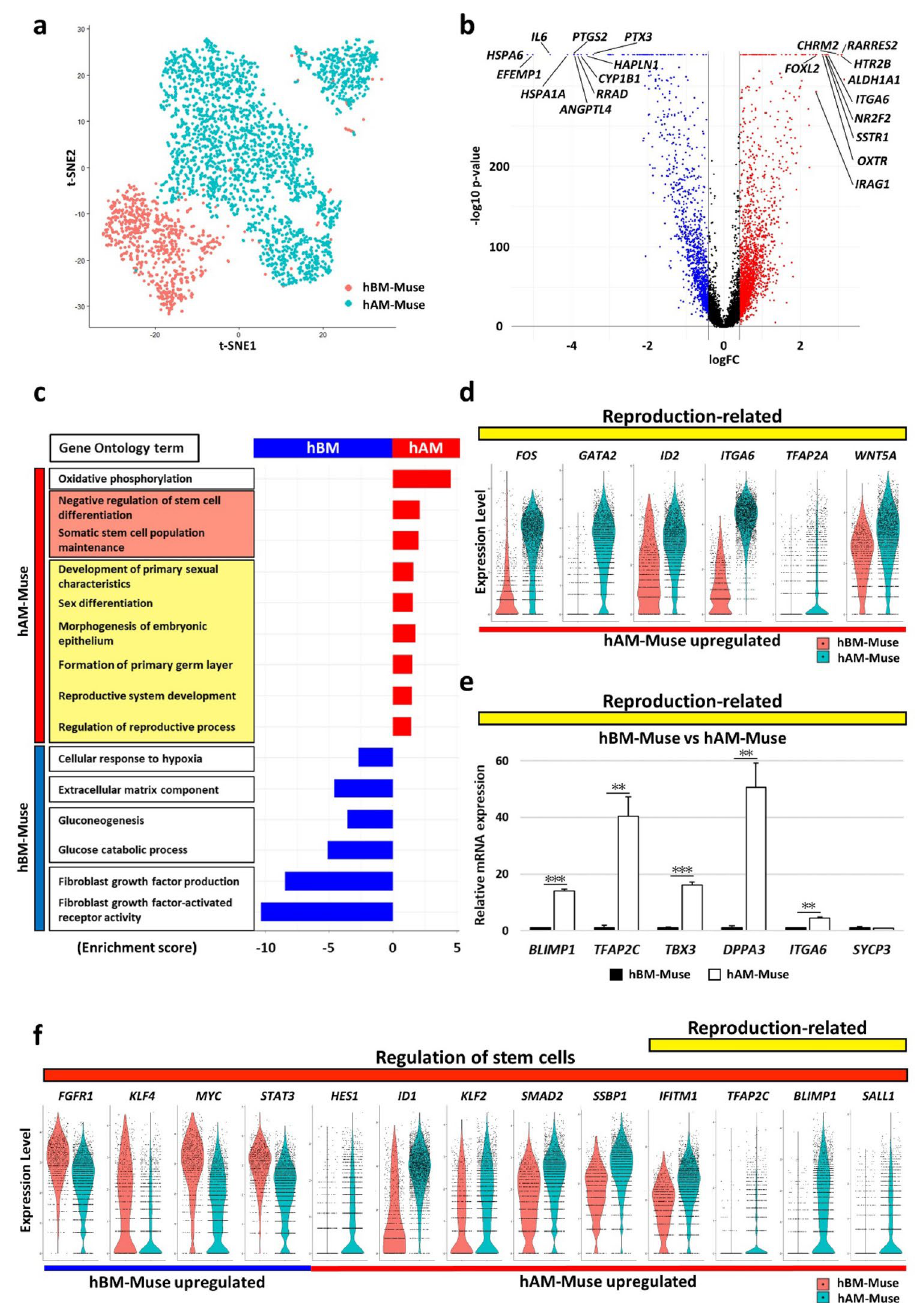
Figure 2. Comparison of hAM- and hBM-Muse cells in scRNA-seq. ( a ) t-SNE plot of hAM- and hBM-Muse cells. ( b ) Volcano plot displaying gene expression levels in hAM-Muse cells compared with those in hBM-Muse cells. Significantly differentially expressed genes were defined as those with a fold-change > 1.5 times or < 0.67 times in hAM-Muse cells compared with hBM-Muse cells, with p < 0.05. Upregulated genes are shown in red, downregulated genes are shown in blue, and the black lines represent the boundary for identification of upregulated or downregulated genes based on the p -value and fold-change. Top 10 differentially expressed genes in hAM- and hBM-Muse cells are shown. ( c ) GO analysis; upregulated genes in hAM- (red) and hBM-Muse cells (blue) are listed. Enrichment score of each term is shown. ( d ) Violin plot showing the expression levels of reproduction-related genes in hBM- (red) and hAM-Muse cells (blue). ( e ) Expression levels of reproduction- related genes in hBM- and hAM-Muse cells were confirmed by qPCR (normalized by ACTB ). Values of hBM- Muse cells were set as 1. * p < 0.05; ** p < 0.01; *** p < 0.001. ( f ) Violin plot showing the expression levels of genes related to regulation of stem cells in hBM- (red) and hAM-Muse cells